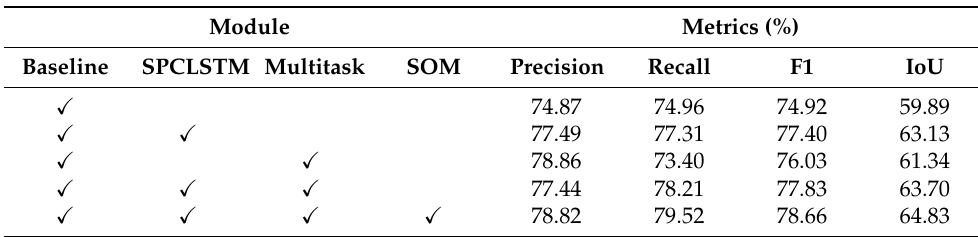
Table 3. Ablation experiments for the network design, where UNet serves as a baseline. (cid:88) indicates the adoption of the corresponding